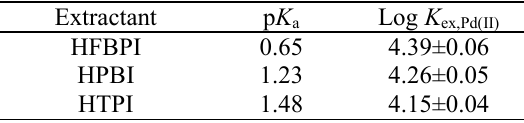
Table 1. Relationship between the extractant p K towards its extraction from acidic chloride solutions using isoxazolones in chloroform.